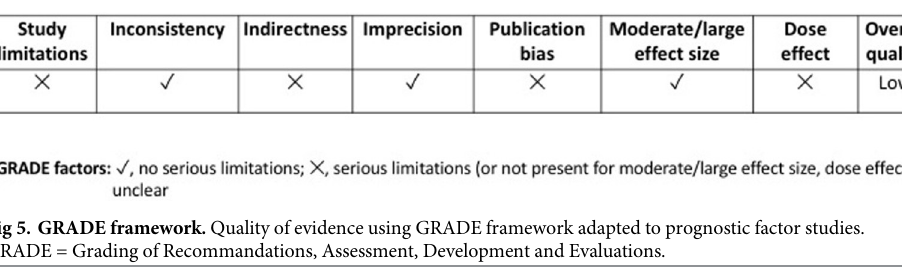
Fig 5. GRADE framework. Quality of evidence using GRADE framework adapted to prognostic factor studies. GRADE = Grading of Recommandations, Assessment, Development and Evaluations.